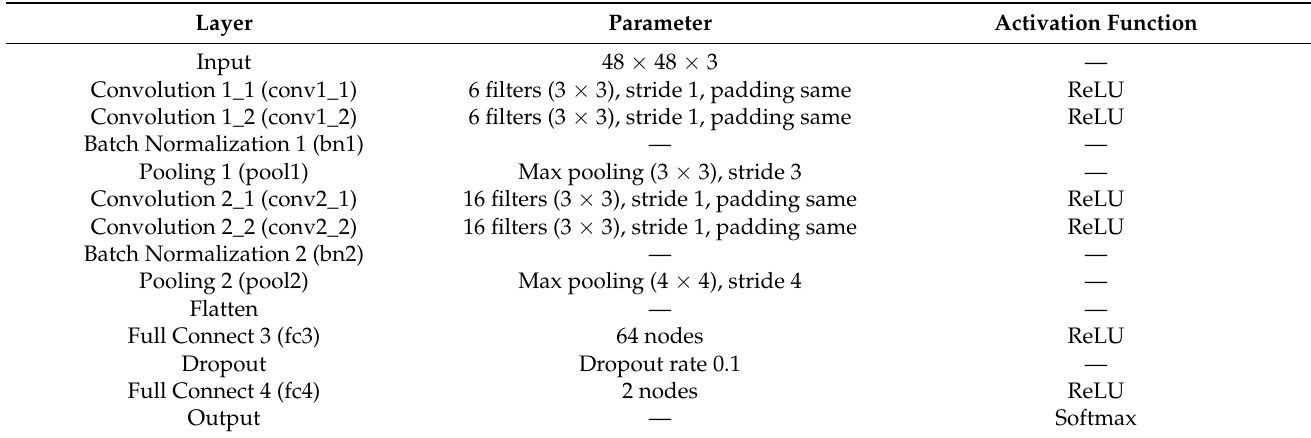
Figure 8. The architecture of the proposed network for rice seedling classification. Table 6. Layer parameters for the proposed network.